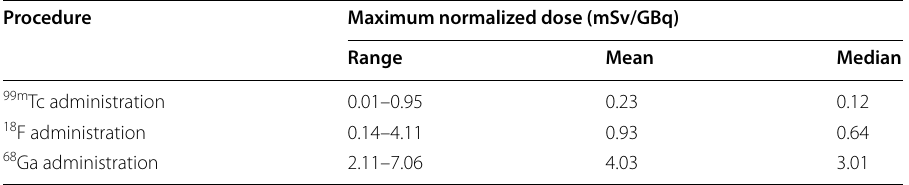
Table 7 Maximum normalized extremity dose values in mSv/GBq for 99m Tc and 18 F, obtained from the ORAMED project [6], and the same data for 68 Ga obtained from this study, inferred from Table